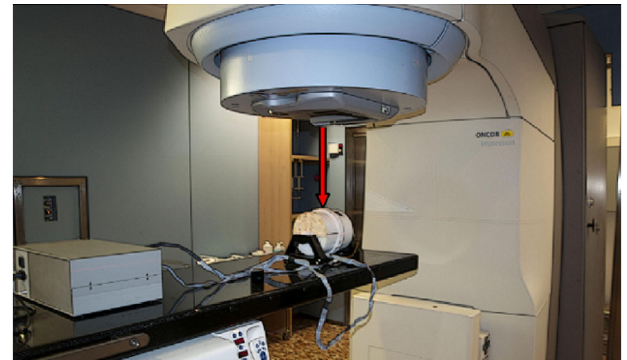
FIG. 1. Experimental setup showing the accelerator’s head where the collimating system is installed, and the cylindrical phantom described in Sec. II. The arrow shows the direction of the